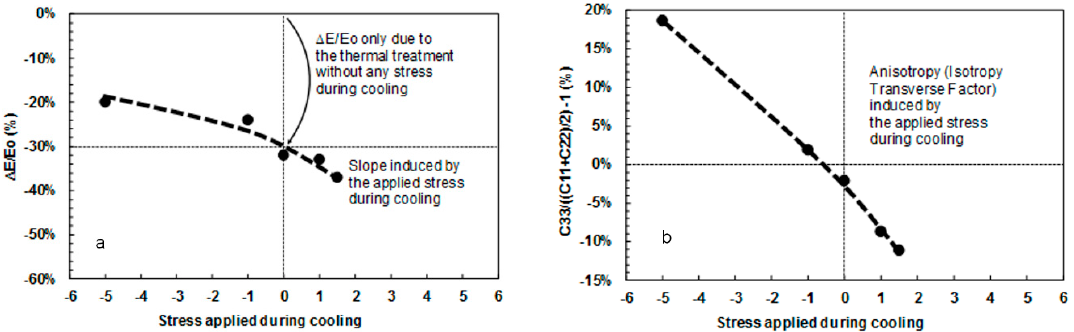
Figure 9. Room temperature elastic properties evolution due to thermal cycling (and cooling under applied stress, where axis 3 is the direction of the applied stress): ( a ) Decrease in Young’s modulus measured along the direction of the applied load and ( b ) evolution of the anisotropy index.